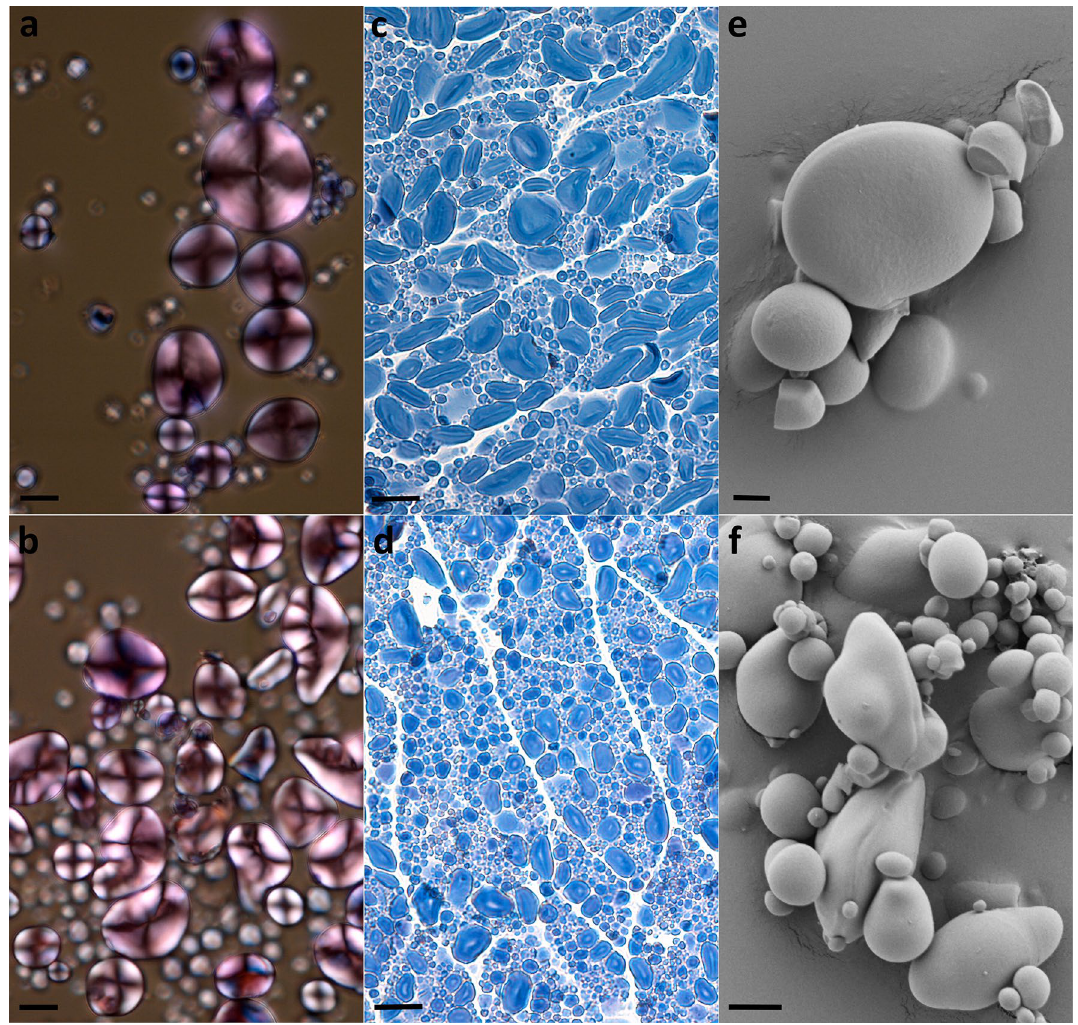
Figure 3. Light and scanning electron microscopy of the sibling control (top panels: a , c,e ) and triple ssIIIa mutant (bottom panels: b , d , f ). Panels ( a , b ) are images of isolated starch stained with Lugol’s solution and viewed with a polarizing filter; size bars represent 10 µm. Panels ( c , d ) are images of grain sections stained with Lugol’s solution; size bars represent 25 µm. Panels ( e , f ) are images of isolated starch; size bars represent 2 µm for panel ( e ) and 5 µm for panel ( f